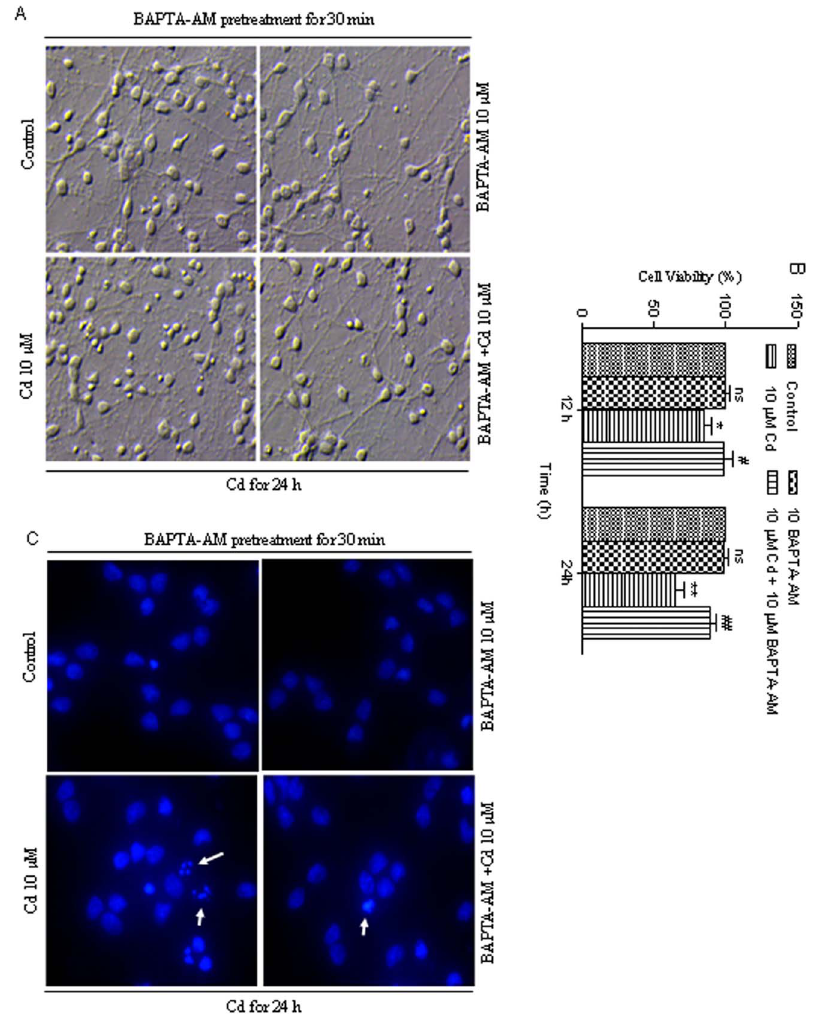
Figure 3. Cd-induced apoptosis arises through calcium-mediated signaling. (A) Morphological alterations in cerebral cortical neurons treated with/without Cd (10 m M) in the presence or absence of BAPTA-AM (10 m M) for 24 h. Morphology of cerebral cortical neurons was assessed using a Leica inverted phase-contrast microscope (400 6 ) equipped with digital camera. All experiments were performed twice. (B) Cell viability of cerebral cortical neurons treated with/without Cd (10 m M) in the presence or absence of BAPTA-AM (10 m M) for 12 and 24 h. Results are presented as mean 6 SD (n=6). *Statistical significance between control and Cd treatment (5, 10 and 20 m M); # Statistical significance between cells cultured in the absence and presence of BAPTA-AM. ns Not significant; * P , 0.05, ** P , 0.01; # P , 0.05, ## P , 0.01, using Student’s t-test. (C) Cd-induced apoptosis were suppressed by BAPTA-AM. Cells were pretreated with BAPTA-AM (10 m M) for 30 min, followed by treatment with Cd (10 m M) for another 24 h to determine apoptosis by Hoechst 33258 staining under a fluorescence microscope (arrows, apoptotic cells). The original magnification is 400 6 . All experiments were performed twice.